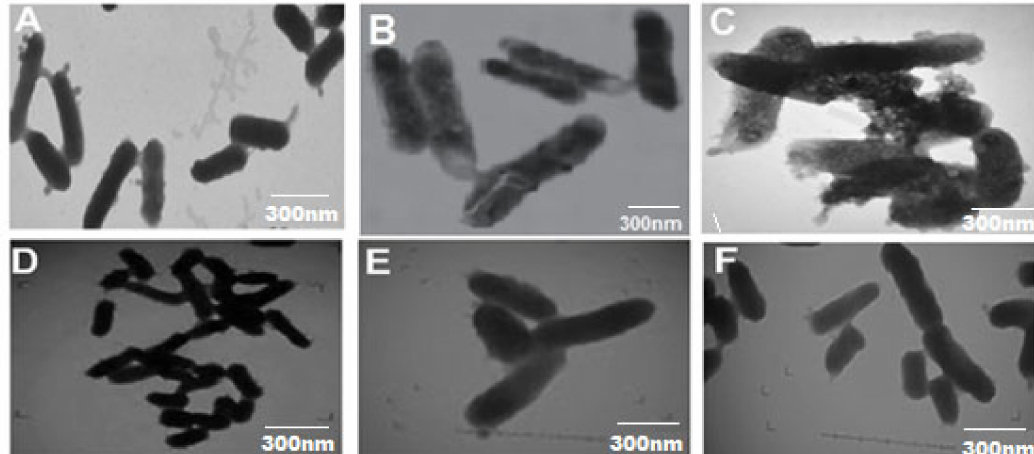
Figure 7. TEM micrographs displaying ultrastructural changes in MDR E. coli cells treated with CIP-Ag/TiO 2 /CS nanohy- bridat MIC (0.0512 µ g/mL) and at different intervals of time. ( A ) Untreated MDR E. coli cells, ( B ) MDR E. coli cells after 6 h of incubation, ( C ) MDR E. coli cells after 12 h of incubation, ( D ) E. coli with CIP at 0 h of incubation ( E ) CIP at 6 h, and ( F ) CIP at 12 h of E. coli treatment.